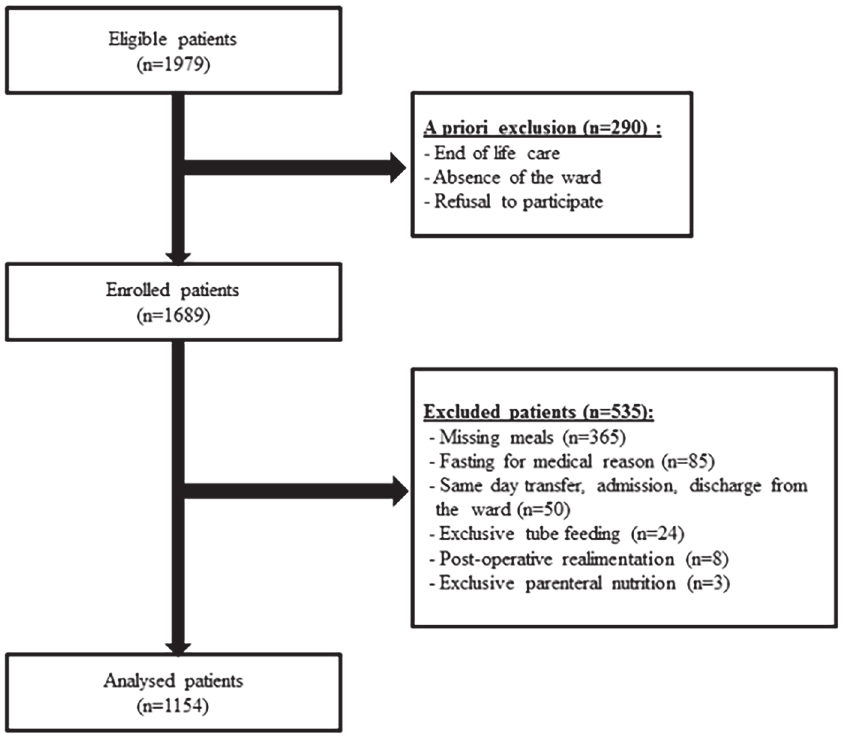
Fig 1. Study flow